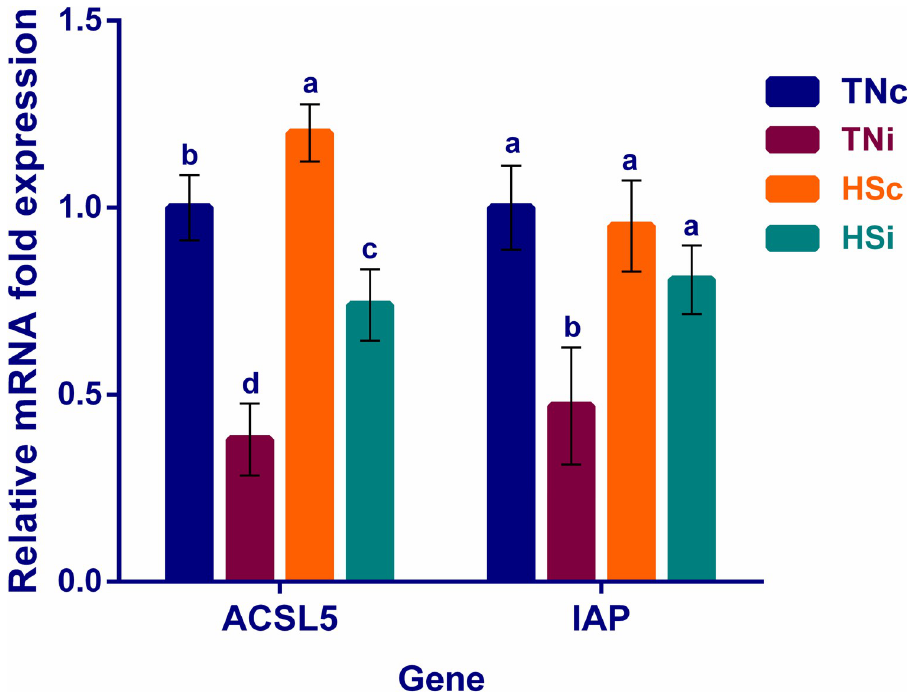
Fig 7. The mRNA expression of the ileal villus absorptive enterocytes’ marker genes. The mRNA fold expression of marker genes specific for ileal villus absorptive enterocytes at 6 dpi of chickens infected with E . maxima and their uninfected controls that are raised in a thermoneutral or heat stress environment: TNc = thermoneutral control, TNi = thermoneutral infected, HSc = heat stress control, HSi = heat stress infected. Significant differences (p < 0.05) were depicted by different letters. The error bars represent the